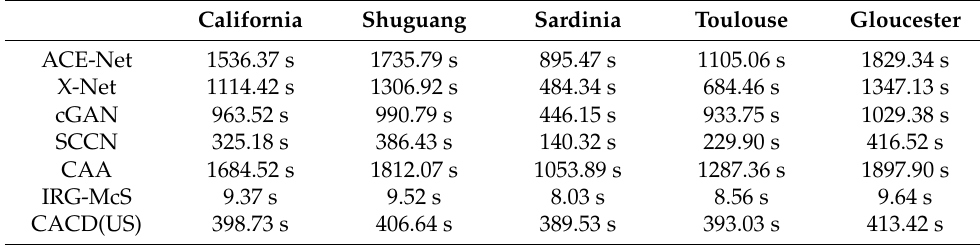
Table 10. Time efficiency analysis on the five